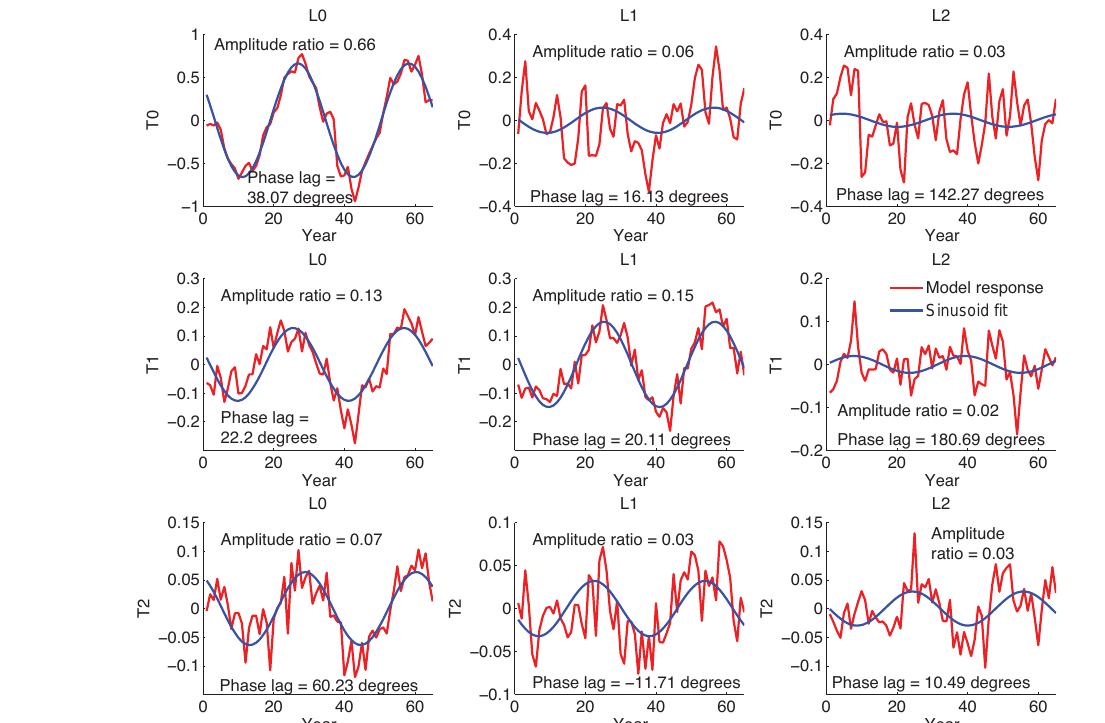
Figure 11. Results for the sinusoidal perturbations in the 3 × 3 design case. Inputs ( L 0 , L 1 , L 2 ) and outputs ( T 0 , T 1 , T 2 ) are described in Sect. 2. Input signal was u ( t ) = 0.01sin(0.2 t ), where 0.01 corresponds to a maximum amplitude of 1% reduction or increase in the